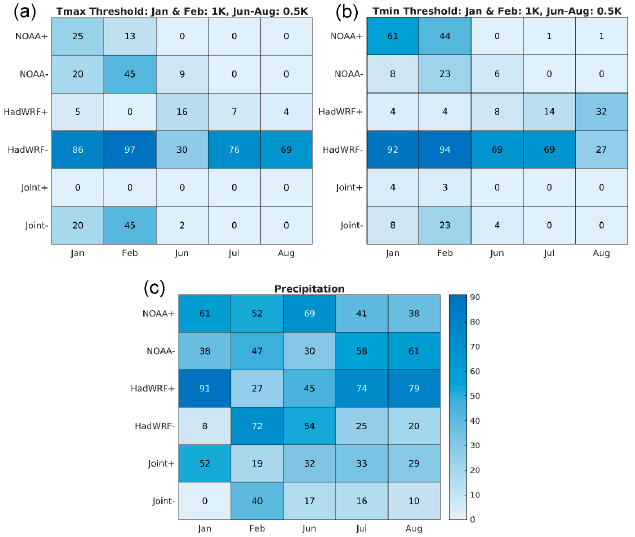
Figure 6. Heatmaps of the percent coverage of the WRF model domain where data from the NOAA ENSO Climate Normals are available, with positive (+) or negative ( − ) mean monthly ( a ) Tmax, ( b ) Tmin, or ( c ) precipitation differences; strong El Niño minus weak La Niña in the NOAA ENSO Climate Normals, the HadGEM2-WRF model chain, and in both (joint) in the historical climate. Note that in these analyses all differences from HadGEM2-WRF are evaluated at the WRF grid resolution and that thresholds used for the Tmax and Tmin differences are different in summer (0.5 K) and winter (1 K).